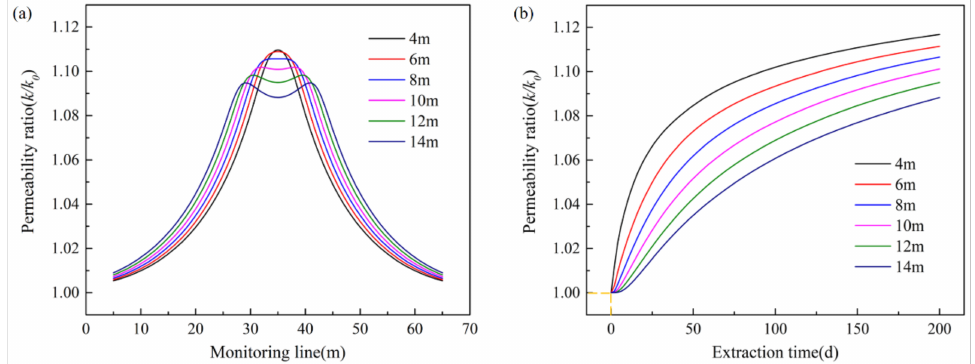
Figure 22. Monitoring data of permeability of monitoring line and monitoring point. ( a ) Variation law of permeability with monitoring line at different borehole spacing. ( b ) The law of permeability variation with time with two